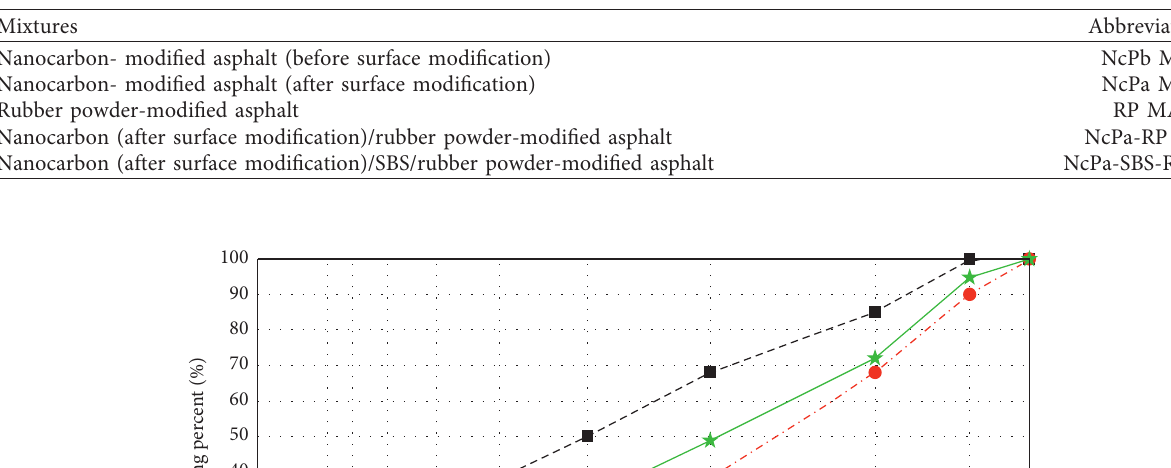
Table 5: Abbreviation of the mixtures.